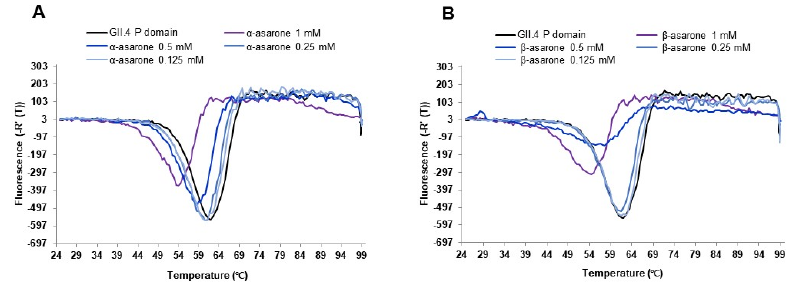
Figure 3. Differential scanning fluorimetry (DSF) profile of the effect of α -asarone and β -asarone on the HuNV GII.4 P domain stability. The effect of ( A ) α -asarone or ( B ) β -asarone on P domain stability was evaluated using DSF assay.